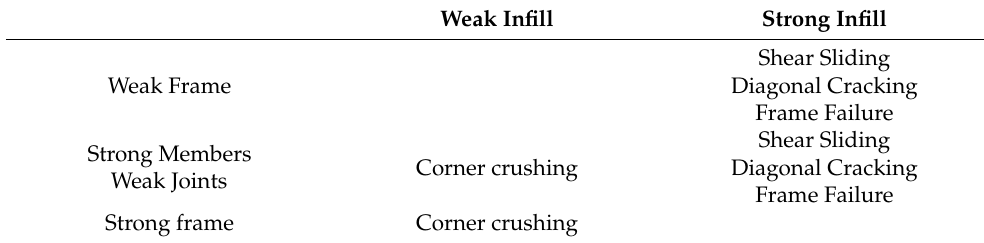
Table 2. Prediction of failure relating the strength of the frame and infill